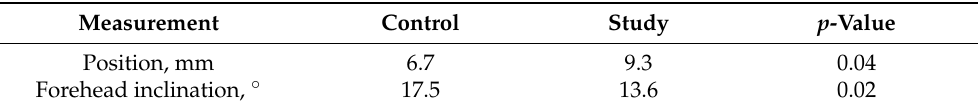
SD: standard deviation. Table 3. Anteroposterior position of the maxillary central incisors and the forehead inclination in the control and the study groups.